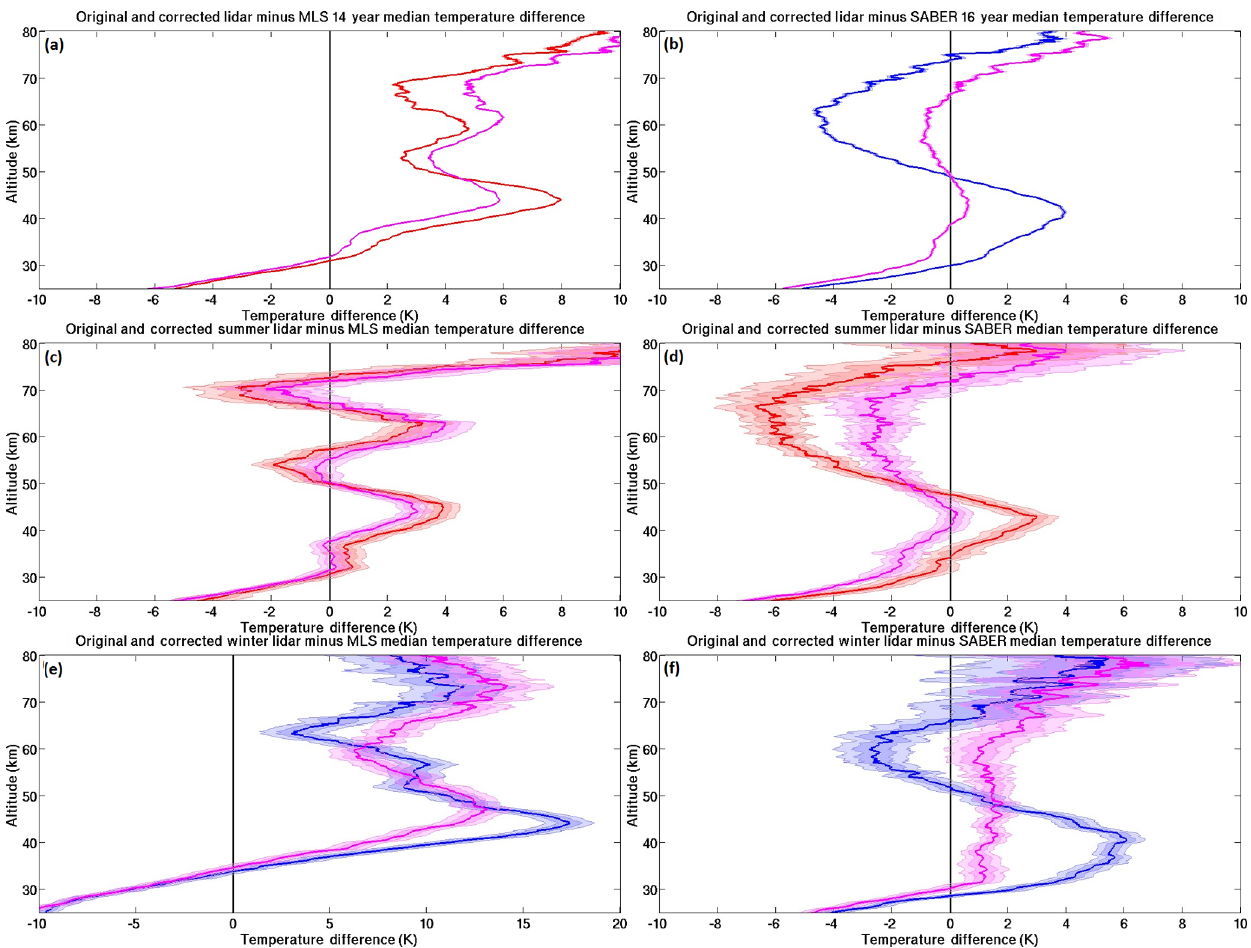
Figure 14. Ensemble for lidar minus MLS temperature differences are in the left column (a, c, e) and lidar minus SABER are in the right column (b, d, f) . Ensembles for all profiles are in the top row (a, b) , summer (MJJA) profiles in the middle row (c, d) , and winter (NDJF) in the bottom row (e, f) . The uncorrected ensembles are in red and blue, and the ensembles after correction of the satellite stratopause altitude are in magenta. Panel (a) shows the median temperature difference for 1741 lidar minus MLS temperature profiles from 2004 to 2018, panel (c) shows the 554 lidar–MLS comparisons occurring during the summer (MJJ), and panel (e) shows the 653 lidar–MLS comparisons occurring during the winter (NDJF). Panel (b) shows the median temperature profiles from 2002 to 2018, panel (d) shows the 306 lidar– SABER comparisons occurring during the summer (MJJA), and panel (f) shows the 397 lidar–SABER comparisons occurring during the winter